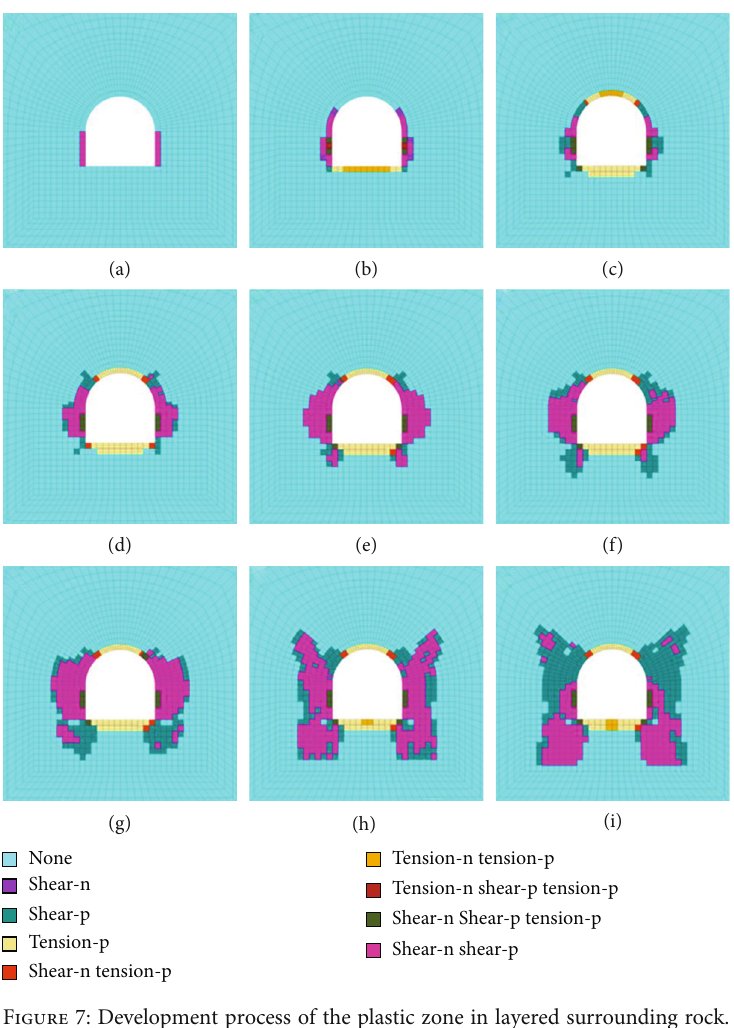
Figure 7: Development process of the plastic zone in layered surrounding rock.